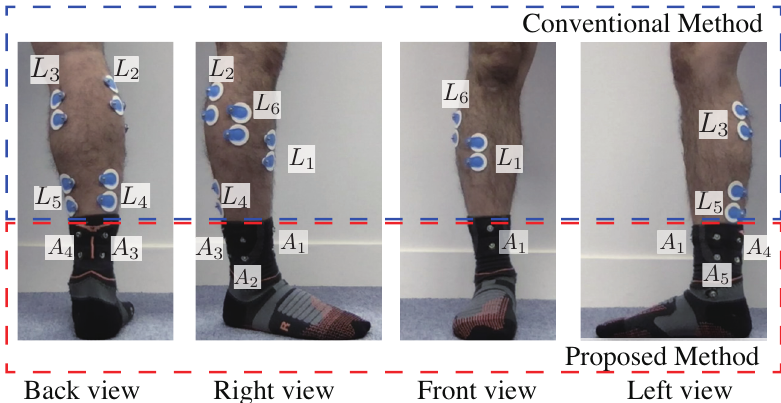
Figure 6. Electrode positions for the right lower leg. A 1 - A 5 are proposed positions. EMG signals from targeted muscles are obtained from L 1 - L 6 .